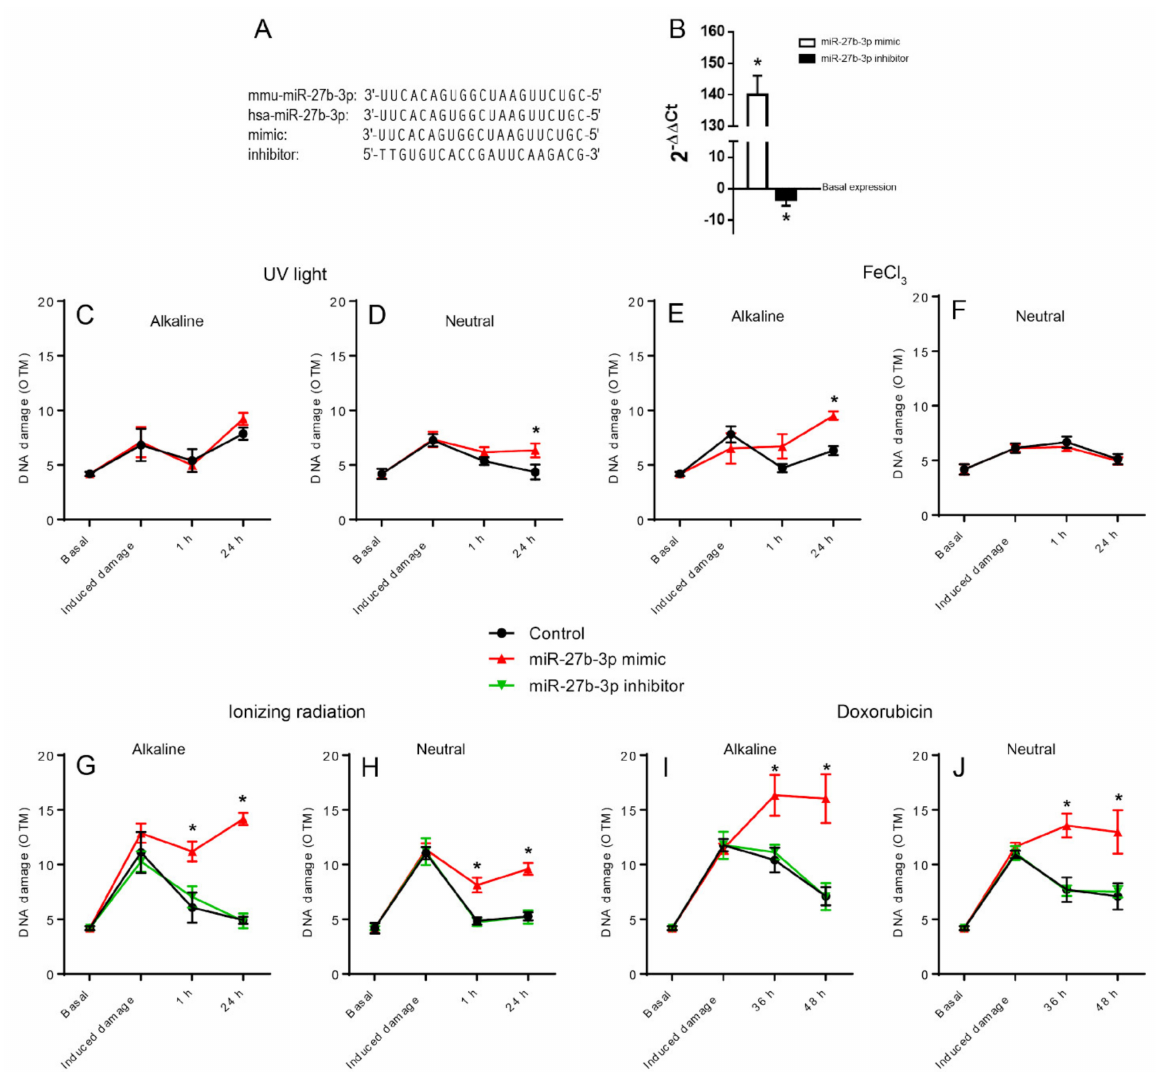
Figure 1. Overexpression of miR-27b-3p reduces DNA repair capacity. ( A ) Alignment of human and murine miR-27b-3p sequences; mimic and inhibitor sequences employed. ( B ) Quantification of miR-27b-3p expression in mimic and inhibitor transfected in BALB/c-3T3 cells. The data of each experimental condition were normalized with respect to the basal expression of Rnu6. The normalized data are expressed with respect to the control and presented as mean ± SD from three replicas using the Ct comparative method and Student’s t -test [41]. ( C – J ) Measurement of DNA damage induced by four DNA damaging agents at three post-treatment time intervals in cells transfected with miR-27b-3p mimic, inhibitor, and control through alkaline and neutral comet assays. ( C , D ) UV light (126 mJ); ( E , F ) ferric chloride (50 µ M/1 h); ( G , H ) ionizing radiation (7.5 Gy); ( I , J ) doxorubicin (50 µ M/1 h). Representative comet images are included in Figure S1. DNA damage is represented as Olive Tail Moment (OTM) [40]. OTM values are presented as mean ± SD from 3 independent experiments. (*) Statistically different from the control condition in the same interval using ANOVA followed by Dunn’s multiple comparison test ( p <